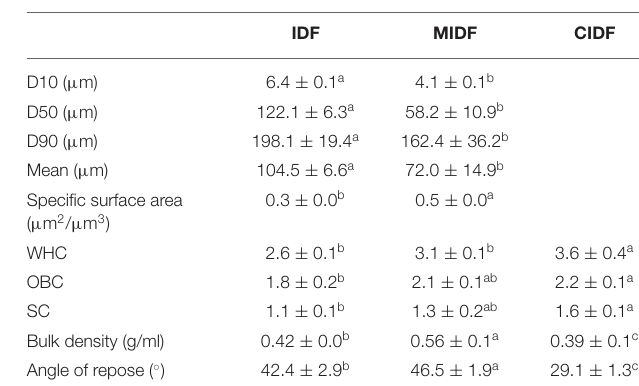
TABLE 1 | Particle sizes of IDF and MIDF, the physicochemical properties (WHC, OBC, SW, BD, and angle of repose) of IDF, MIDF, and